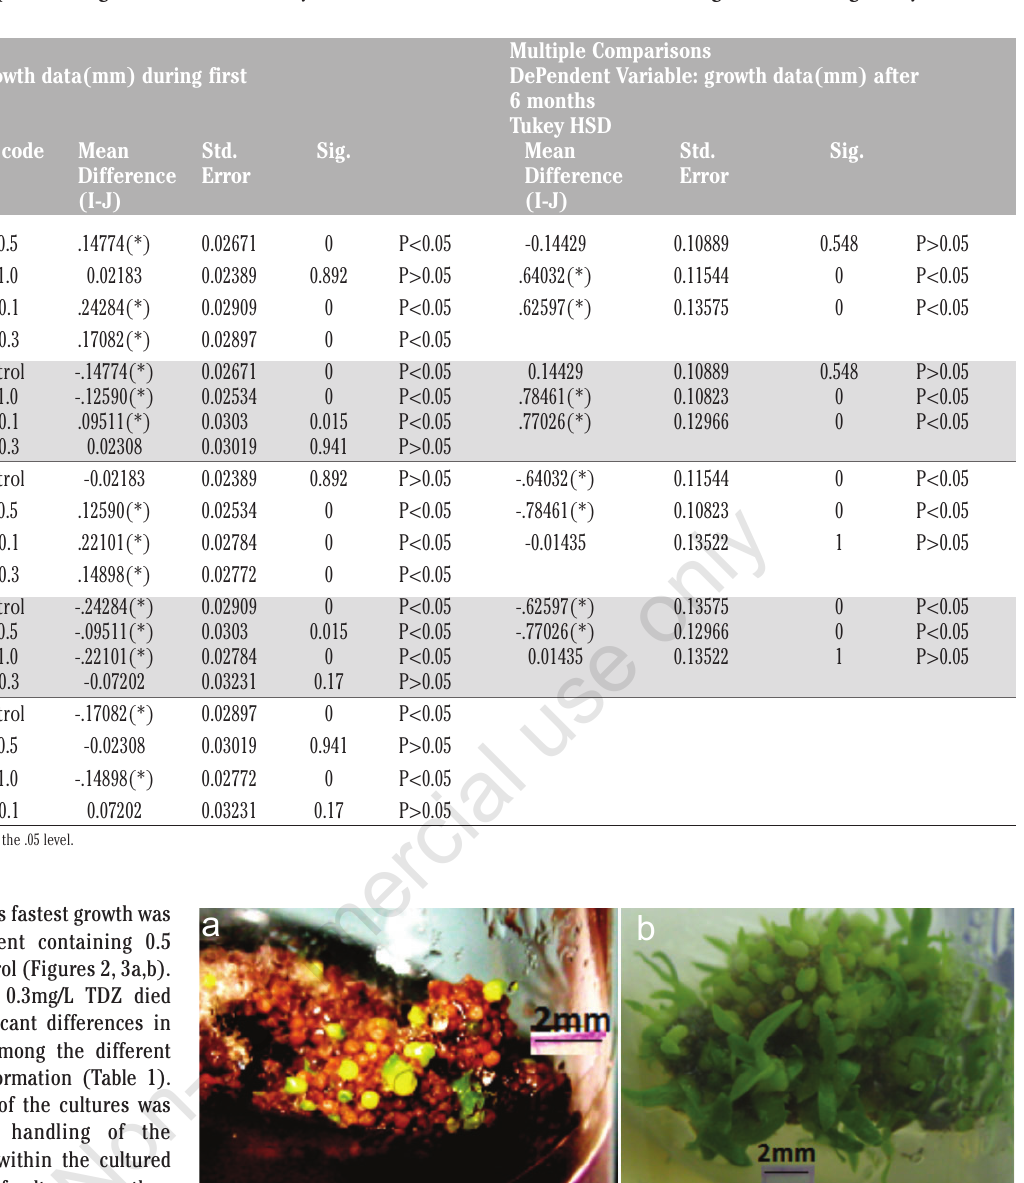
Table 2. Statistical Comparison of growth (mm) of embryos under different PGR treatments following ANOVA using Tukey’s multiPle comParison method. Multiple comparisons Multiple Comparisons DePendent variable: growth data(mm) during